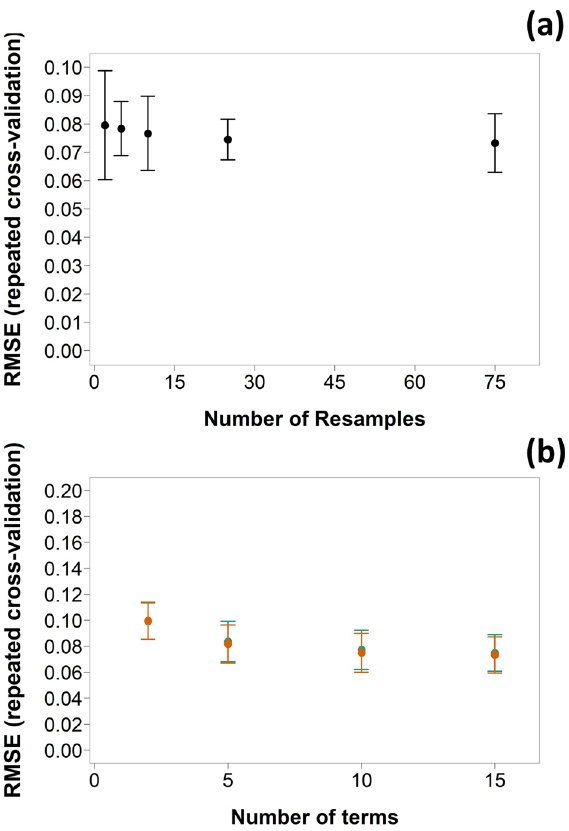
Figure 3. Relation for bag MARS models between RMSE (mean ± SD) for tenfold cross validation repeated 3 times and ( a ) number of resamples and ( b ) number of terms and degree of correlation (n = 1 ■ , n = 2 ■ ) (number of resamples =